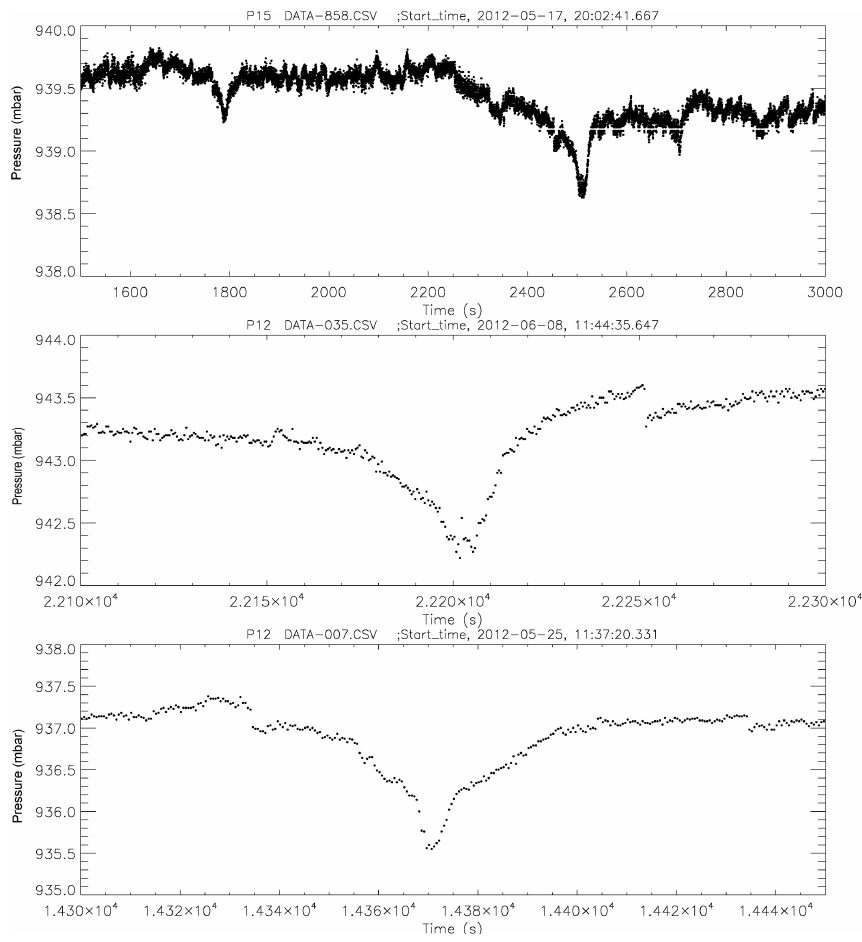
Fig. 10. Further dust devil signatures. (a) A 0.4mbar 60s event and a 0.6mbar 100s event, spaced by 700s. (b) A 1mbar event, 500s long, with an apparent double dip in pressure, perhaps due to a core wandering in a cycloidal pattern (c) the largest event noted so far, 1.5mbar deep, 100s wide, with a distinct 0.6mbar 10s-wide core. Note each plot is scaled differently. Data are uncorrected for sawtooth